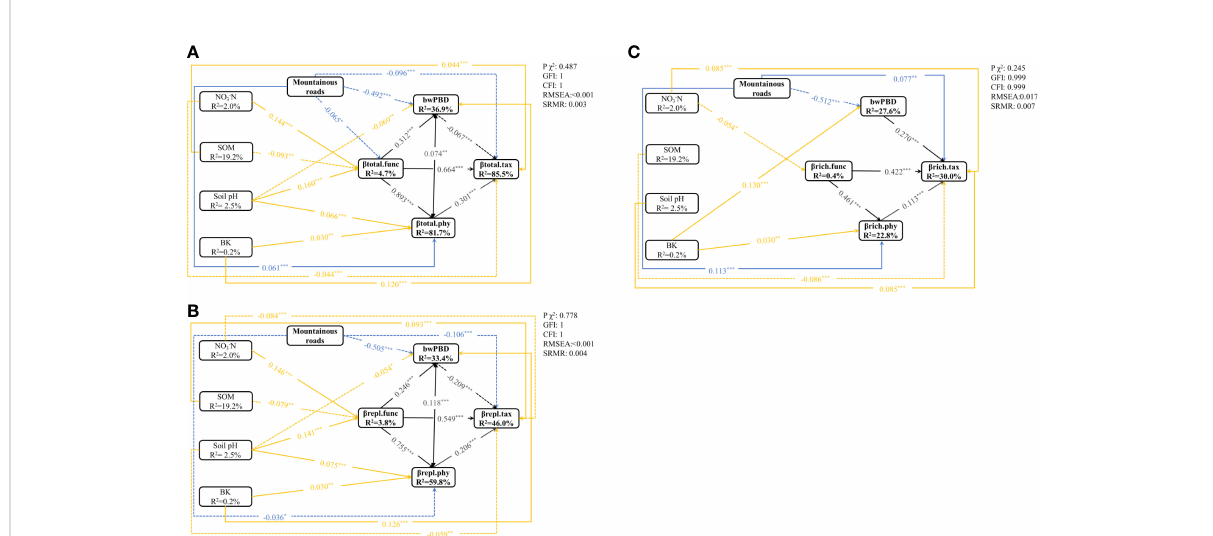
FIGURE 5 The SEM showed direct and indirect effects of road disturbance, soil variables on b total.tax, b total.func, b total.phy and bwPBD (A) , b repl.tax, b repl.func, b repl.phy and bwPBD (B) , and b rich.tax, b rich.func, b rich.phy and bwPBD (C) (n=703). Boxes indicate measured variables and arrows indicate relationships among variables. Double-headed arrows and single-headed arrows represent a correlative relationship and a causal relationship, respectively. The relationships between the three facets of beta diversity are shown as black lines, the impact of roads on beta diversity is shown as blue lines, and the yellow lines represent the impact of changes in soil physicochemical properties on beta diversity. Solid and broken arrows represent positive relationships and negative effects, respectively. Signi fi cance levels were as follows: * P <0.05, ** P <0.01 and *** P <0.001.